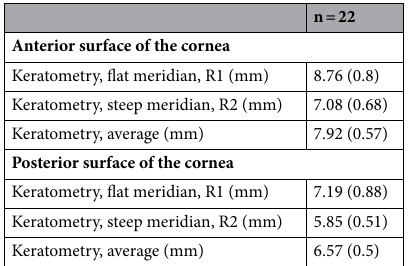
Table 2. The keratometry of the anterior and posterior curvature of the cornea after removal from the donor’s eye measured with SS OCT in eye bank; mean values (± SD).